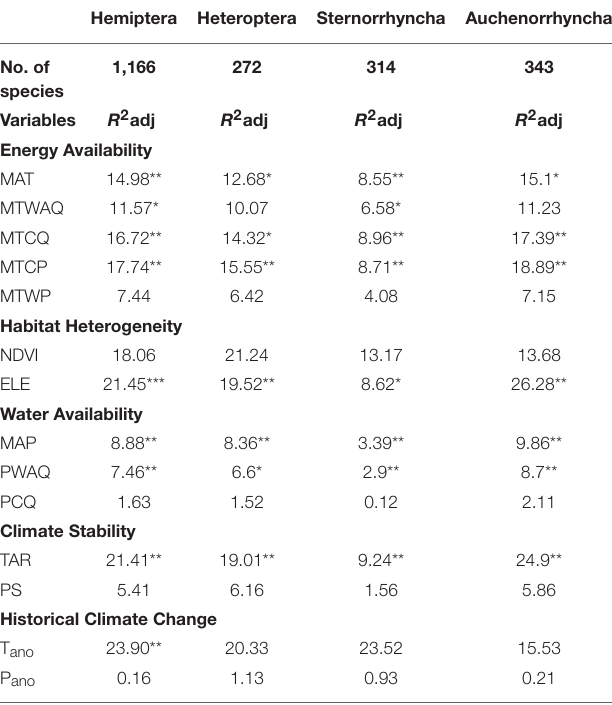
TABLE 1 | Coefficient of determination R 2 adj (%) of the General linear models for all selected variables. Modified t-test was used to test the significance. Hemiptera Heteroptera Sternorrhyncha